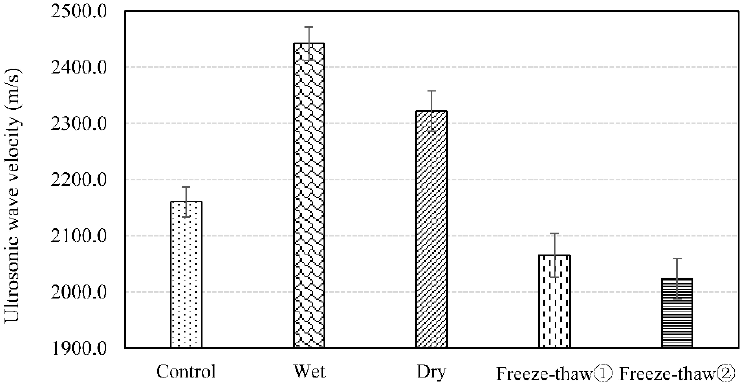
Figure 3. Ultrasonic velocity of Marshall specimens with different environmental conditions.